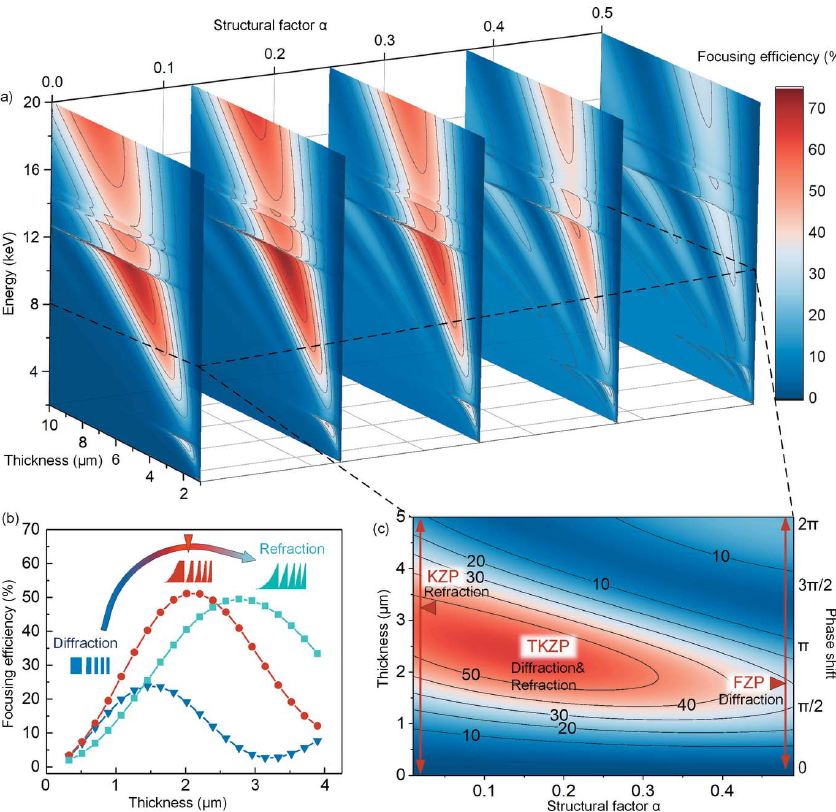
Figure 3 Calculated focusing efficiency (FE) of three different types of zone plate lenses. ( a ) The theoretical focusing efficiency of the TKZP as a function of the structural factor (cid:5) , photon energy and lens thickness, based on the thin grating approximation. The map shares the same color bar with ( c ). ( b ) The focusing efficiencies of the FZP, KZP and TKZP ( (cid:5) = 0.2) calculated by the QDHT-BPM approach at 8 keV. ( c ) Focusing efficiency map in the plane of the structural factor (cid:5) and the lens thickness t at 8 keV, obtained by